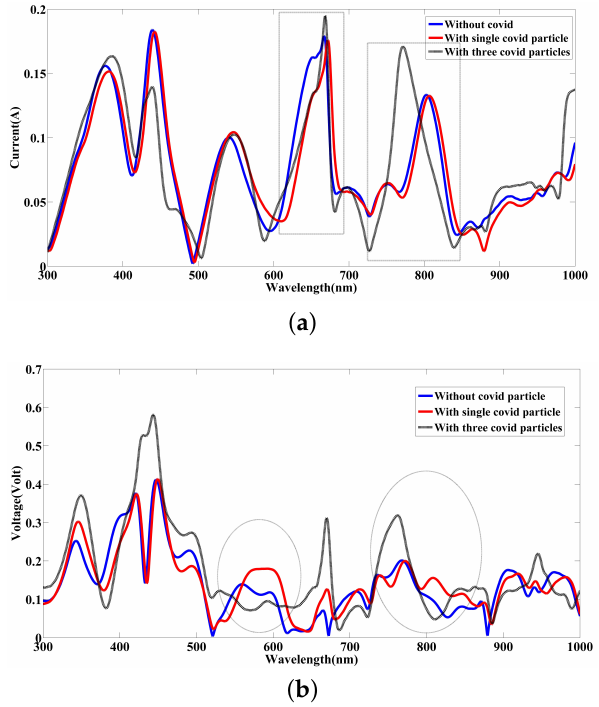
Figure 14. ( a ) The contrast of the current spectra resulted from the different blood samples with and without COVID-19 particles. ( b ) The contrast of the voltage spectra resulted from the various blood samples with and without COVID-19